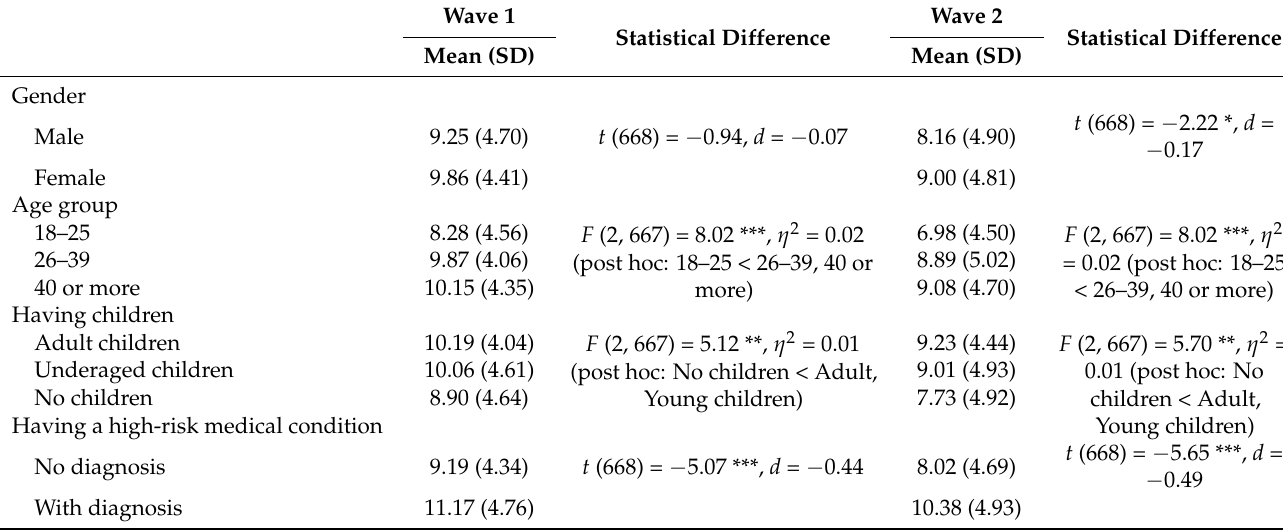
Table 2. Analyses of differences in distress (IES-6 total score) within sociodemographic characteristics for each wave a . Wave 1 Wave Statistical Difference